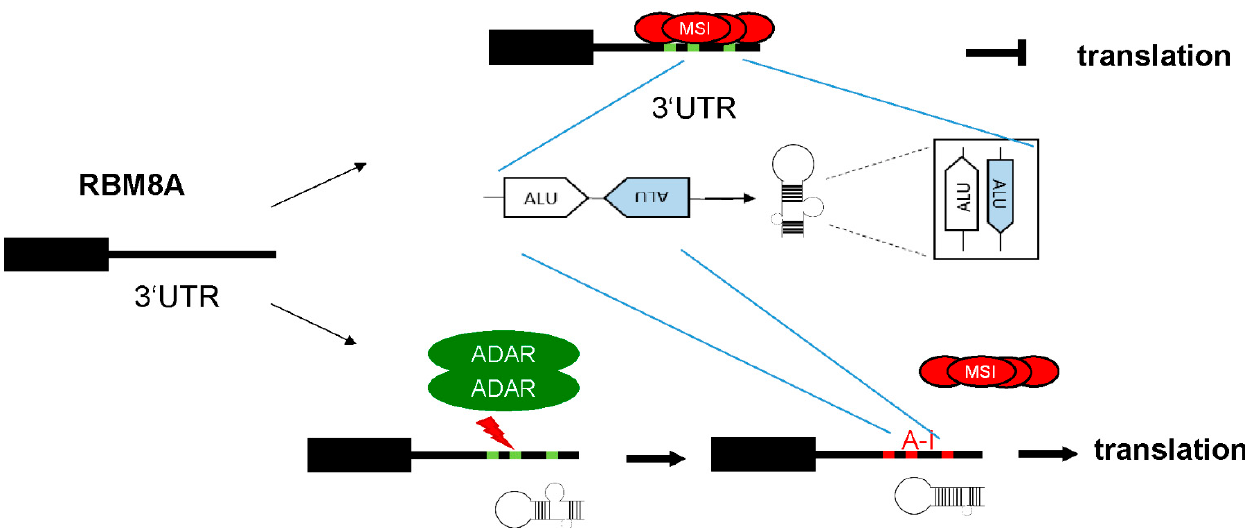
Figure 7. ADAR-dependent editing contributes to maintaining elevated RBM8A protein levels in mesothelioma by counteracting MSI2-driven downregulation.